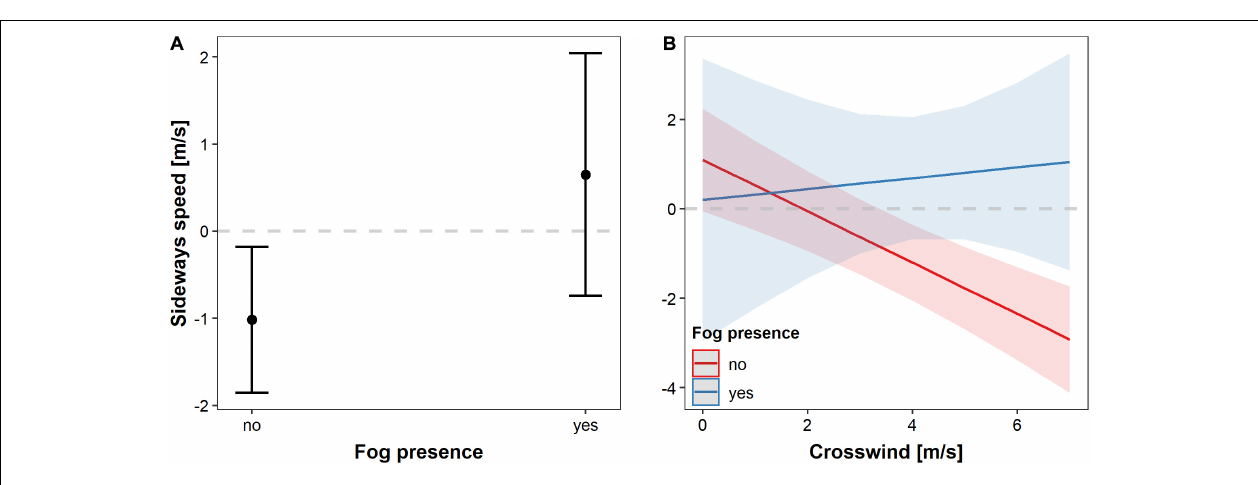
FIGURE 5 | The effects of crosswind on bird sideways speed. (A) Sideways speed mean and 95% C.I. (whiskers) for tracks in foggy and clear weather conditions. (B) Regression slopes and 95% C.I. of the sideways speed in relation to the crosswind component through fog or under clear skies. The dashed line marks the y-intercept at 0 m/s sideways speed, representing the presumable direction of flight toward the migration goal. Crosswinds have only positive values since they only represent the wind blowing from the left to the right side of the average migration